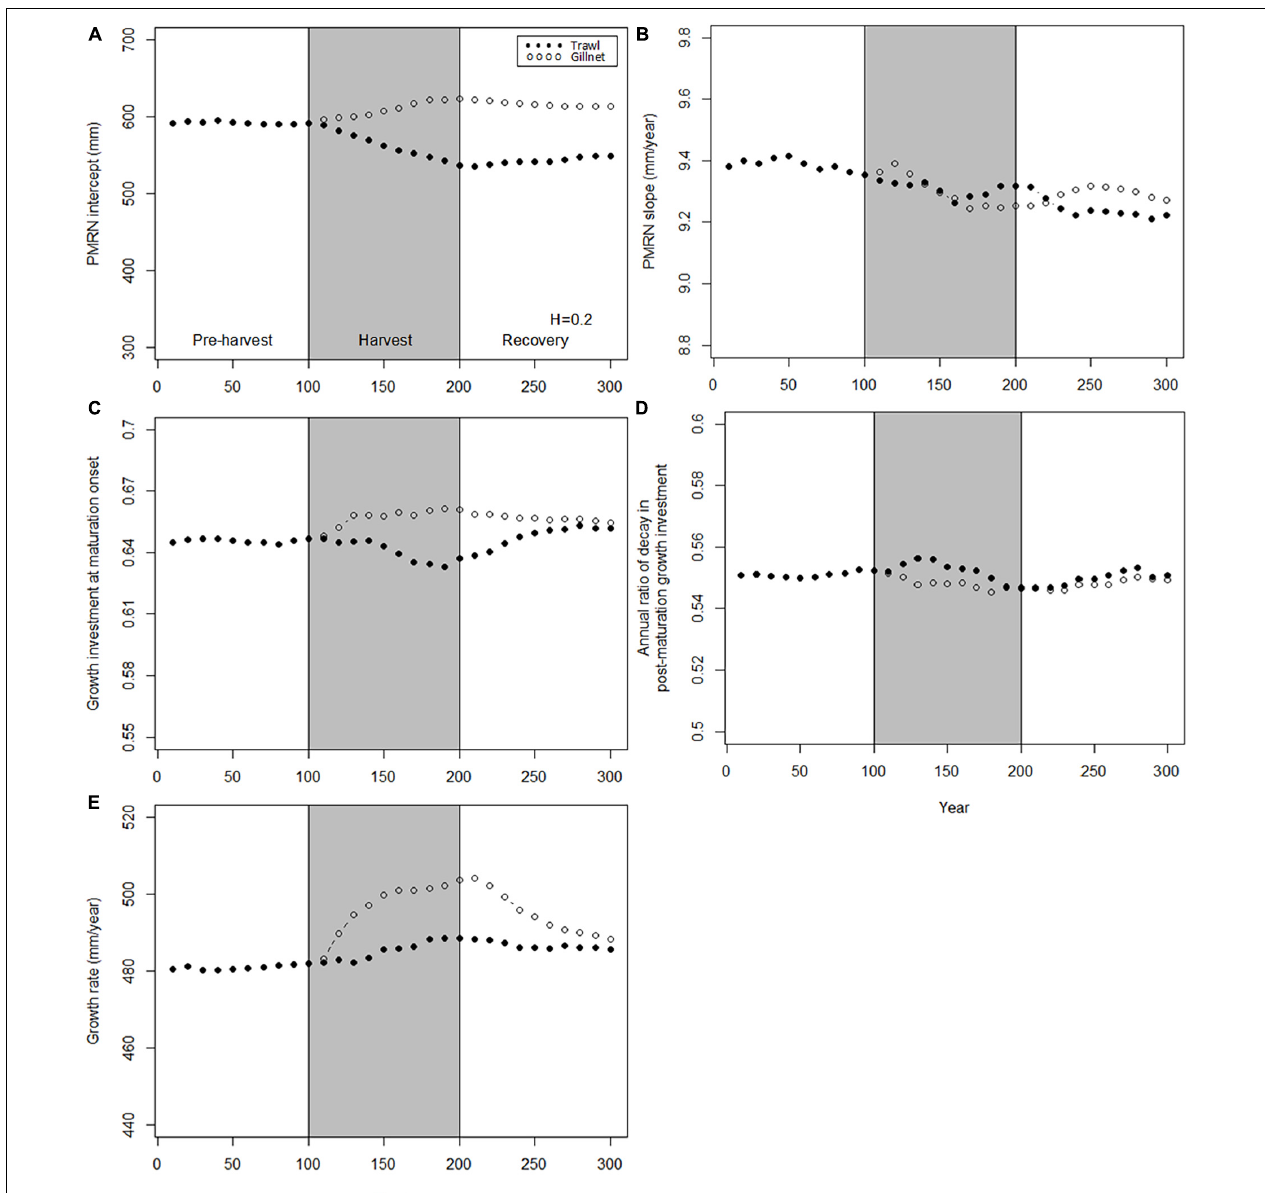
FIGURE 6 | Dynamics of the mean genotypic values of evolving traits before, during and after harvest. Harvest (gray shading) starts at t = 100 years and stop at t = 200 years. Dynamics are shown for two harvest patterns: H = 0.2 year - 1 for trawl (solid points) and H = 0.8 year - 1 for gillnet (hollow points). (A) PMRN intercept y ; (B) PMRN slope s ; (C) Growth investment α at maturation onset; (D) Annual ratio χ of decay in post-maturation growth investment; (E) Juvenile growth rate g